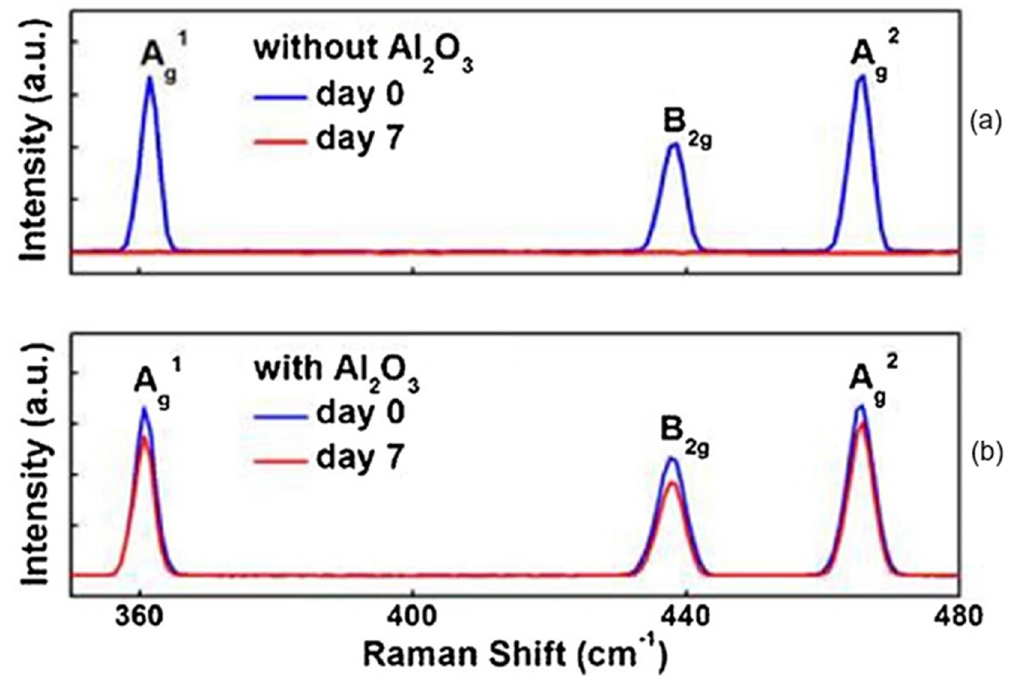
Figure 16. ( a ) Raman spectra of a BP flake without Al 2 O 3 capsulation after exfoliation (blue line) and after 7 days under ambient condition (red line). ( b ) Raman spectra of a 6-nm-thick Al 2 O 3 encapsulated BP flake immediately after exfoliation (blue line) and after 7 days under ambient condition (red line). Reproduced with permission from Ref. [125]. Copyright American Chemical Society, 2017.